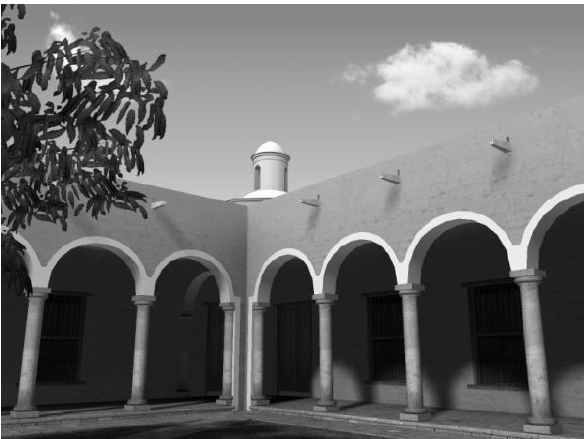
Figure 12. Application example of the styles "window" and "arcade" to specific